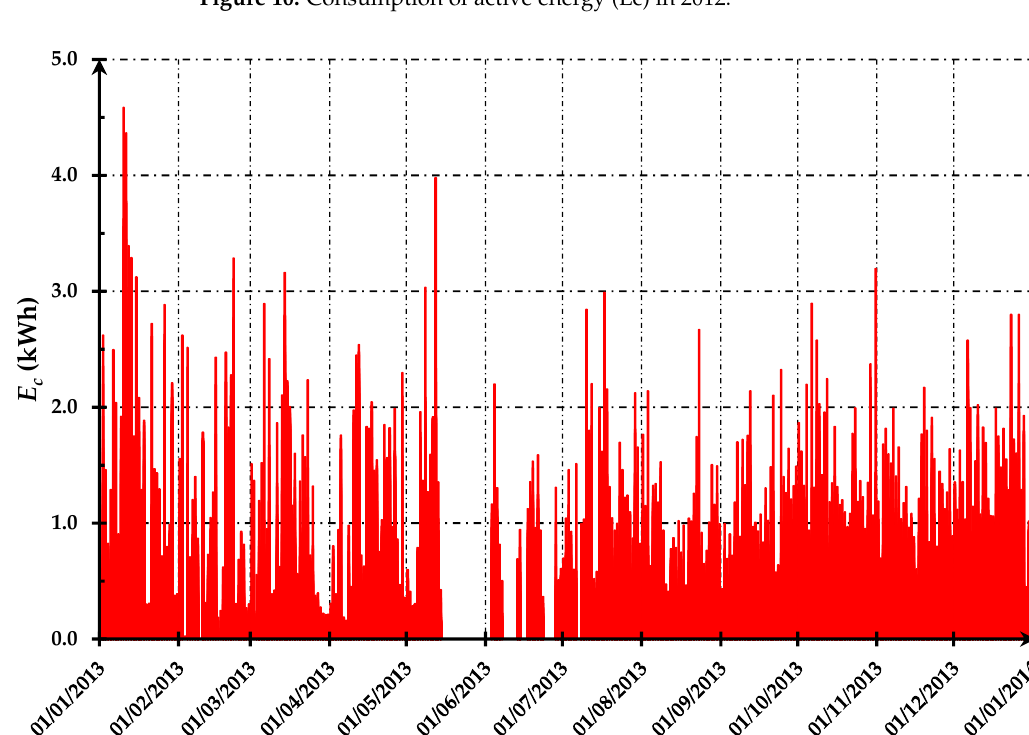
Figure 11. Consumption of active energy (Ec) in 2013.